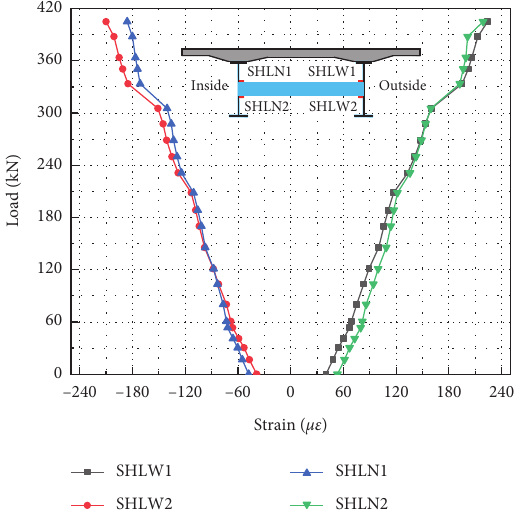
Figure 10: Load-strain curves of the steel crossbeam at the loading section.